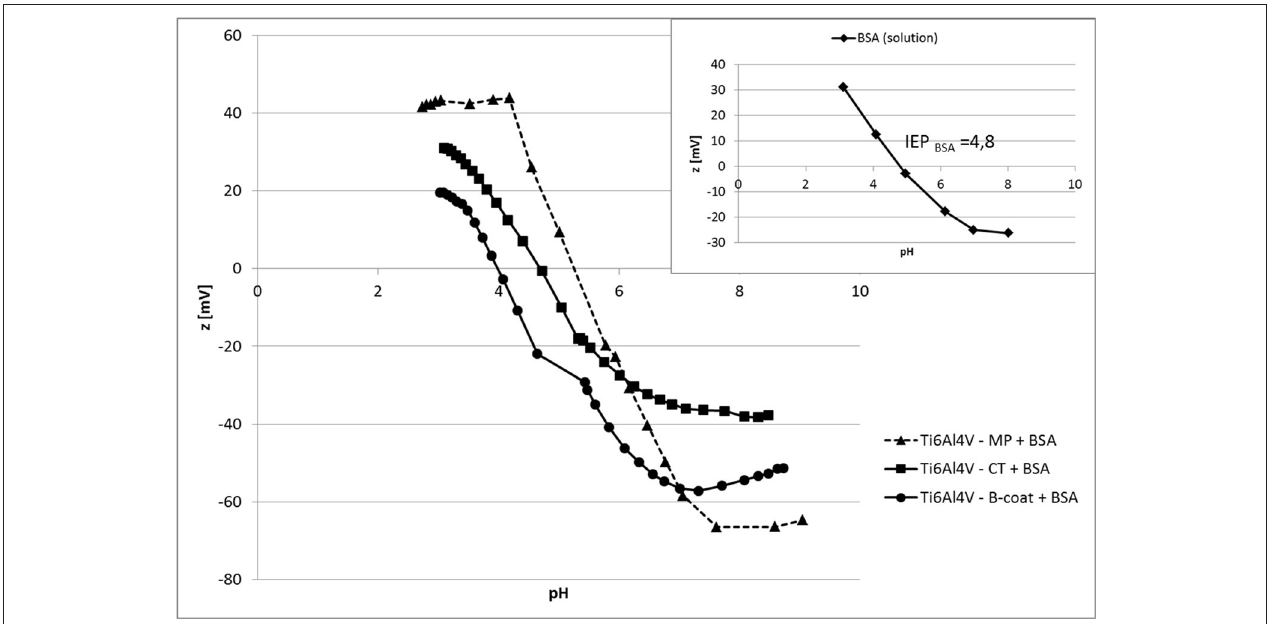
FIGURE 5 | Zeta potential measurements vs. pH of Ti6Al4V – MP, Ti6Al4V – CT, and Ti6Al4V – B-coat after BSA absorption. Insert: zeta potential of an albumin solution (electrophoretic